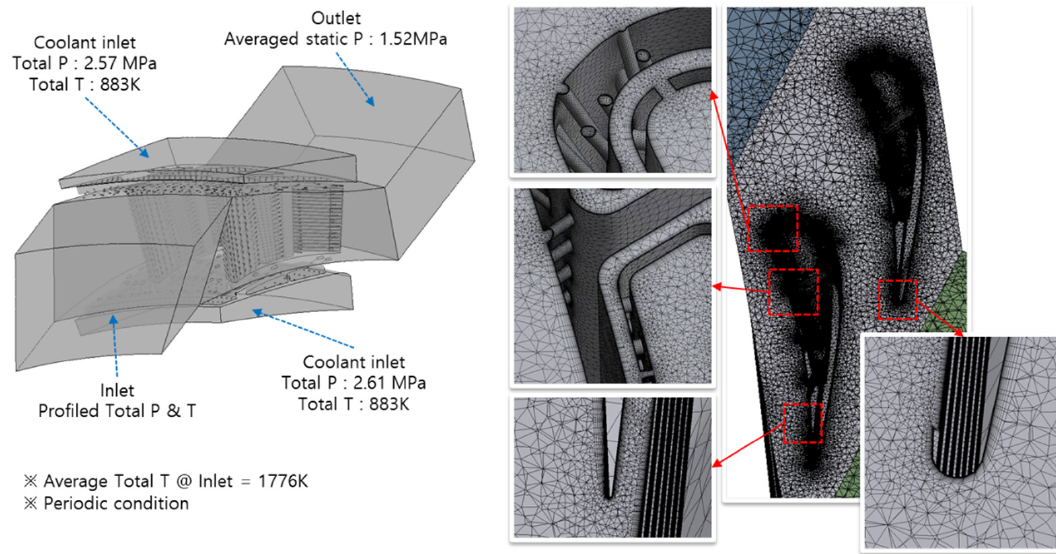
Figure 7. Computational domain including the cooling system and mesh system.